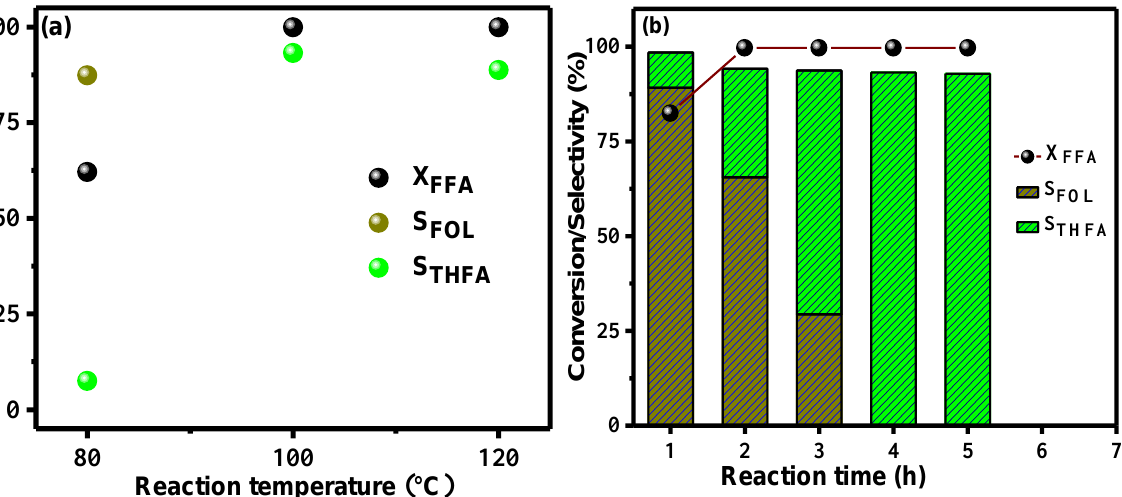
Figure 8. Conversion and selectivity ( a ) at different temperatures for 4 h, and ( b ) with reaction time at 100 °C. Reaction conditions: 0.030 g of 7.5Ni/m-TiO 2 , 1 mmol of furfural, 2 mL of water, and 2 MPa of H 2 pressure.